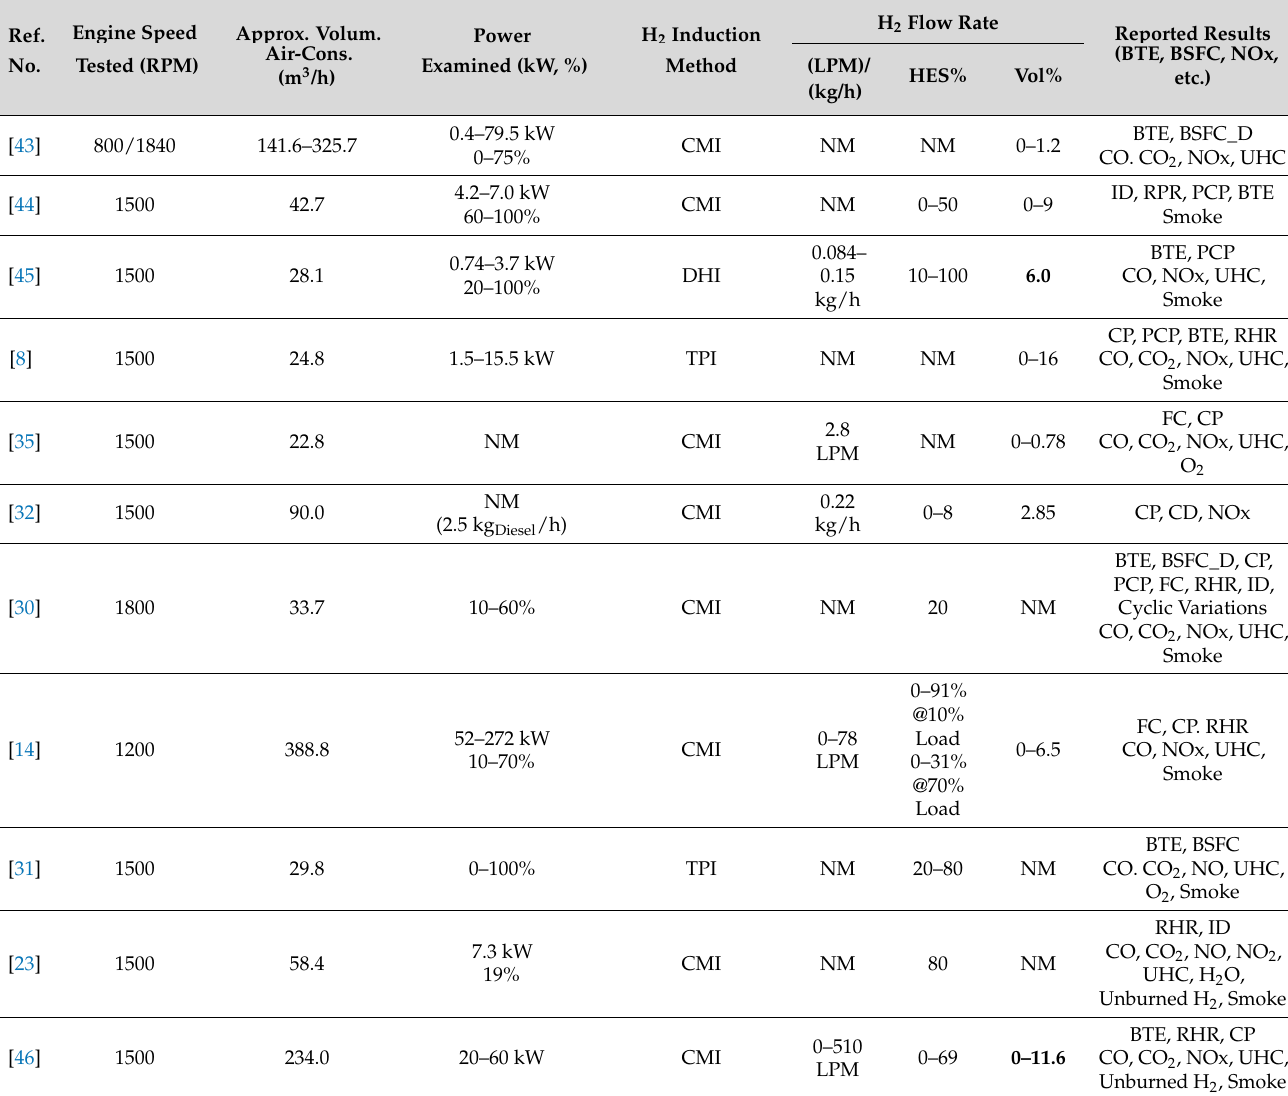
Table 2. Operational parameters that were examined in each study and reported quantities regarding the engine’s performance and emission characteristics. NM corresponds to “Not Mentioned”. The explanation of the abbreviations is given in Nomenclature and Abbreviations